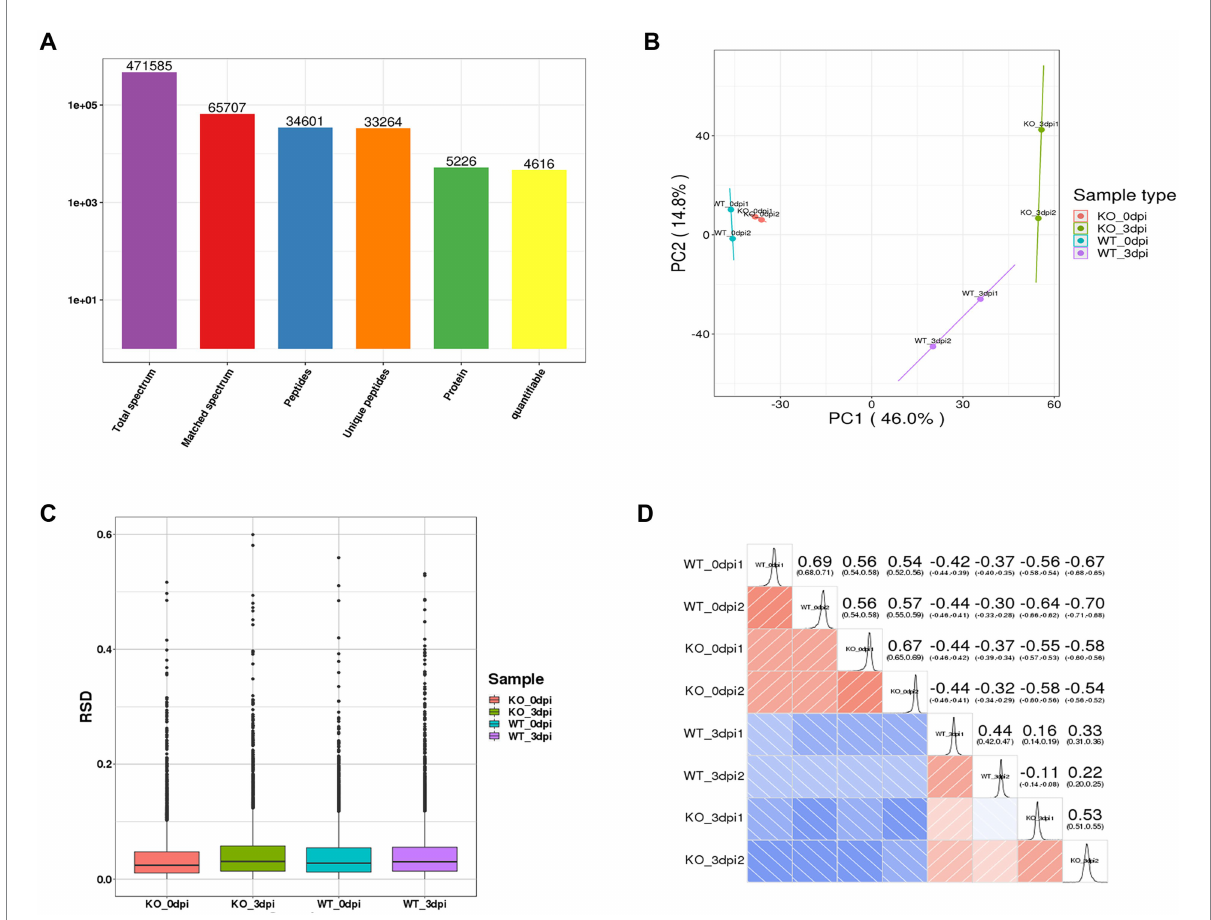
FIGURE 2 General overview of protein analysis. (A) Summary of MS spectrum database search analysis. (B) Plot results of principal component analysis (PCA) for all protein samples. (C) Relative standard deviation (RSD) results of all proteins samples between two replicates. (D) Heat map of Pearson correlation coefficient between all protein samples. The closer to –1 represents the negative correlation, the closer to 1 represents the positive correlation, and the closer to 0 represents no